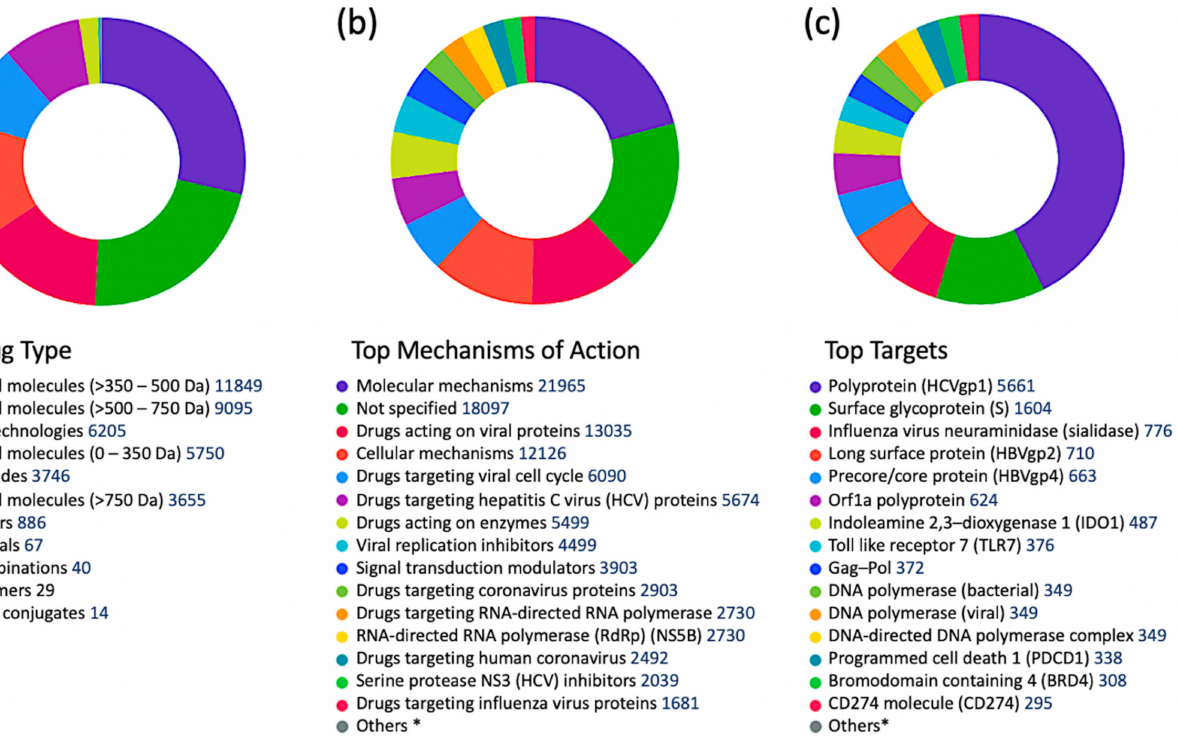
Figure 1. An overview of antiviral drugs according to ( a ) drug type, ( b ) top mechanisms of action, and ( c ) top targets. * Others in b and c indicate that there are other mechanisms and targets that are not shown in the figure because they represent a large number of categories with very small